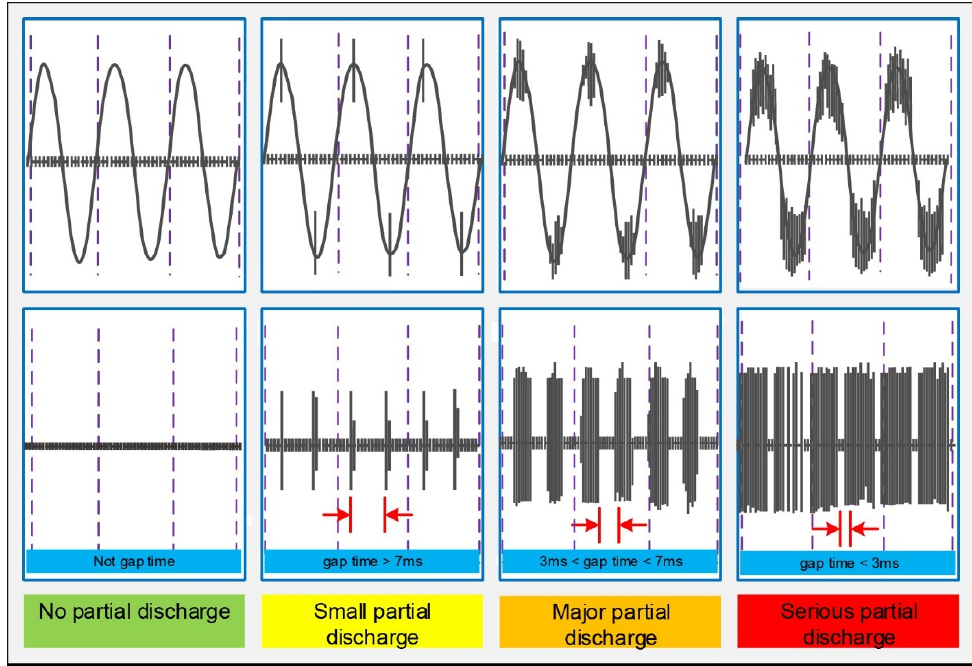
Figure 2. The severity criteria of partial discharge; Gap time.